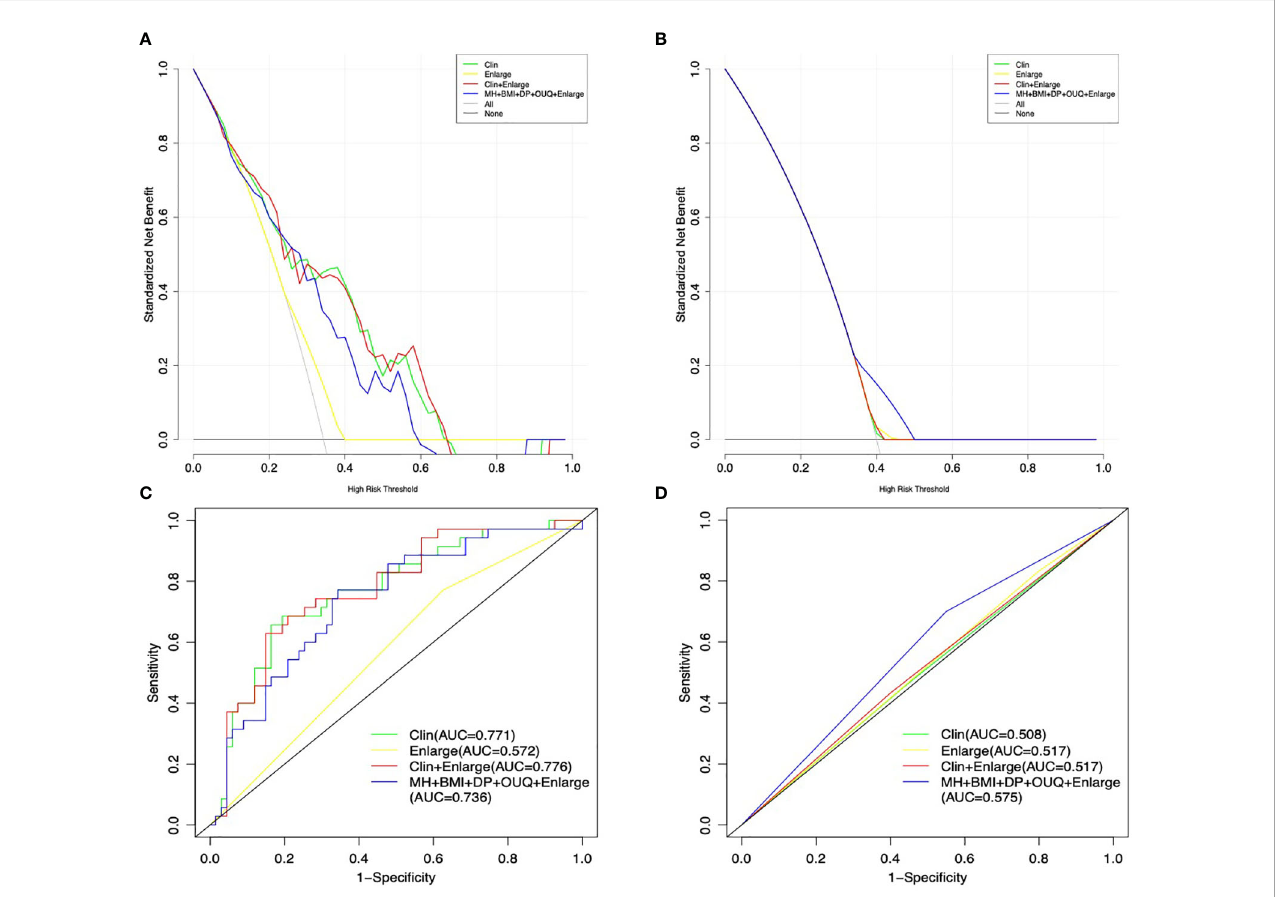
FIGURE 2 Decision curve graphics of all models for predicting Her-2 over-expression patients in the training (A) and test cohort (B) . AUC graphics of all models for predicting Her-2 positive patients in the training (C) and test cohort (D)